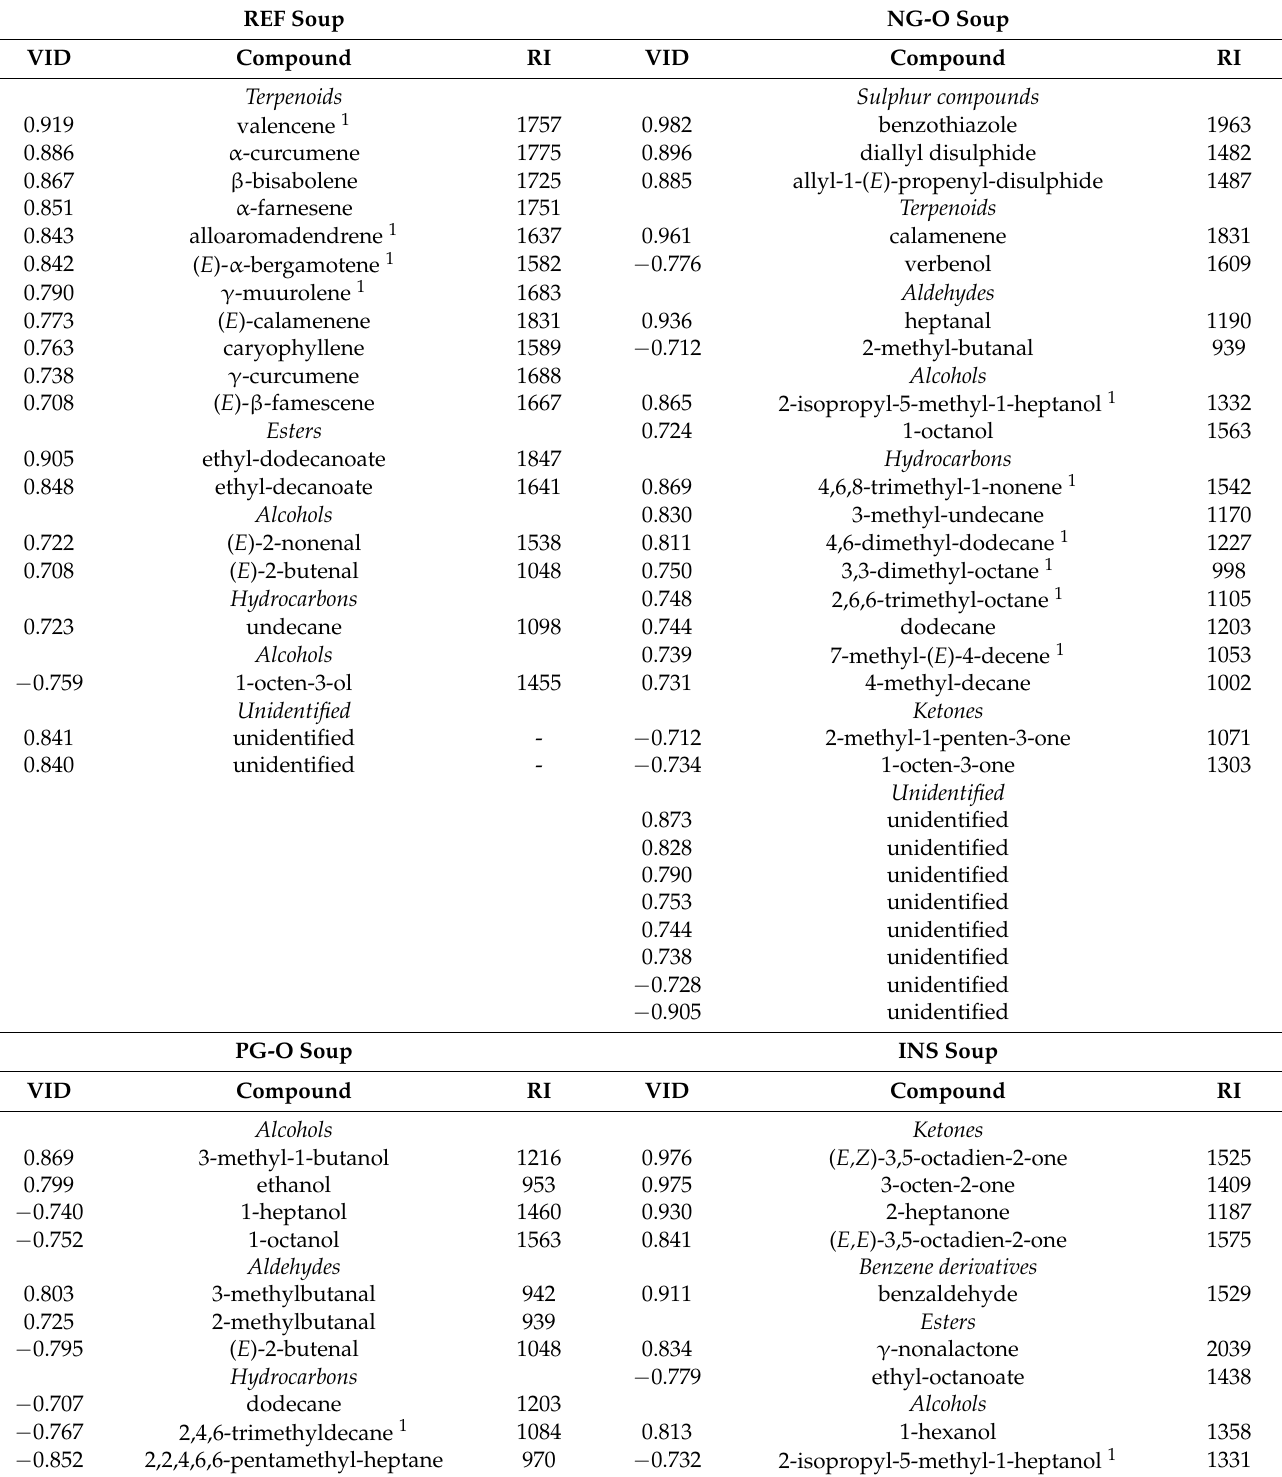
Table 3. Overview of volatile headspace components in reference soup (REF) and soups containing non-gelatinised open cell chickpea flour (NG-O), pre-gelatinised open cell chickpea flour (PG-O), and pre-gelatinised commercially available chickpea flour (INS), selected with the VID procedure (|VID| ≥ 0.7). Components with a positive VID coefficient increase during storage; components with a negative VID coefficient decrease during storage. Volatiles are ranked based on chemical class and VID coefficients. Retention index (RI) on TR-FFAP